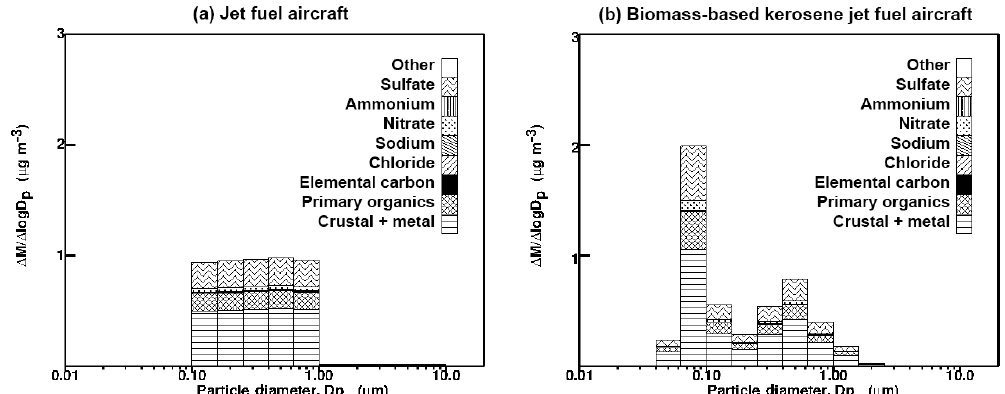
Figure 7. Particle emissions size and composition distribution for jet-fueled aircraft (a) and biomass-based kerosene jet-fueled aircraft (b)